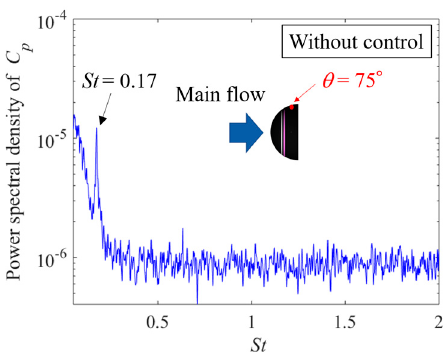
Figure 21. Power spectral density of pressure fluctuations near the string-type PA. The static hole was placed at z/D = 0.0 and θ = 75 deg on the front surface of the test piece.